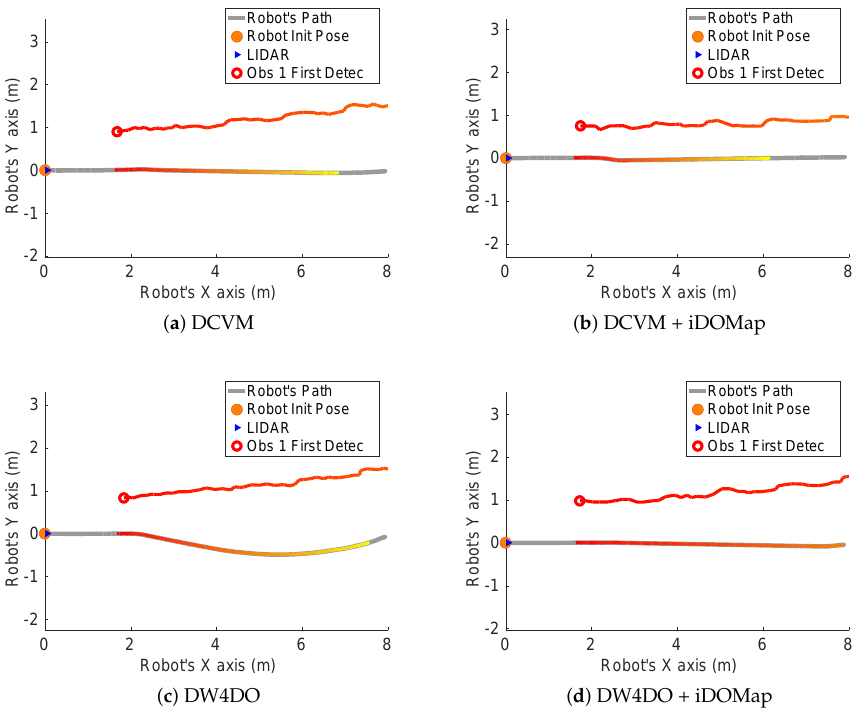
Figure 28. Scenario 1—Robot Paths and iDOMap